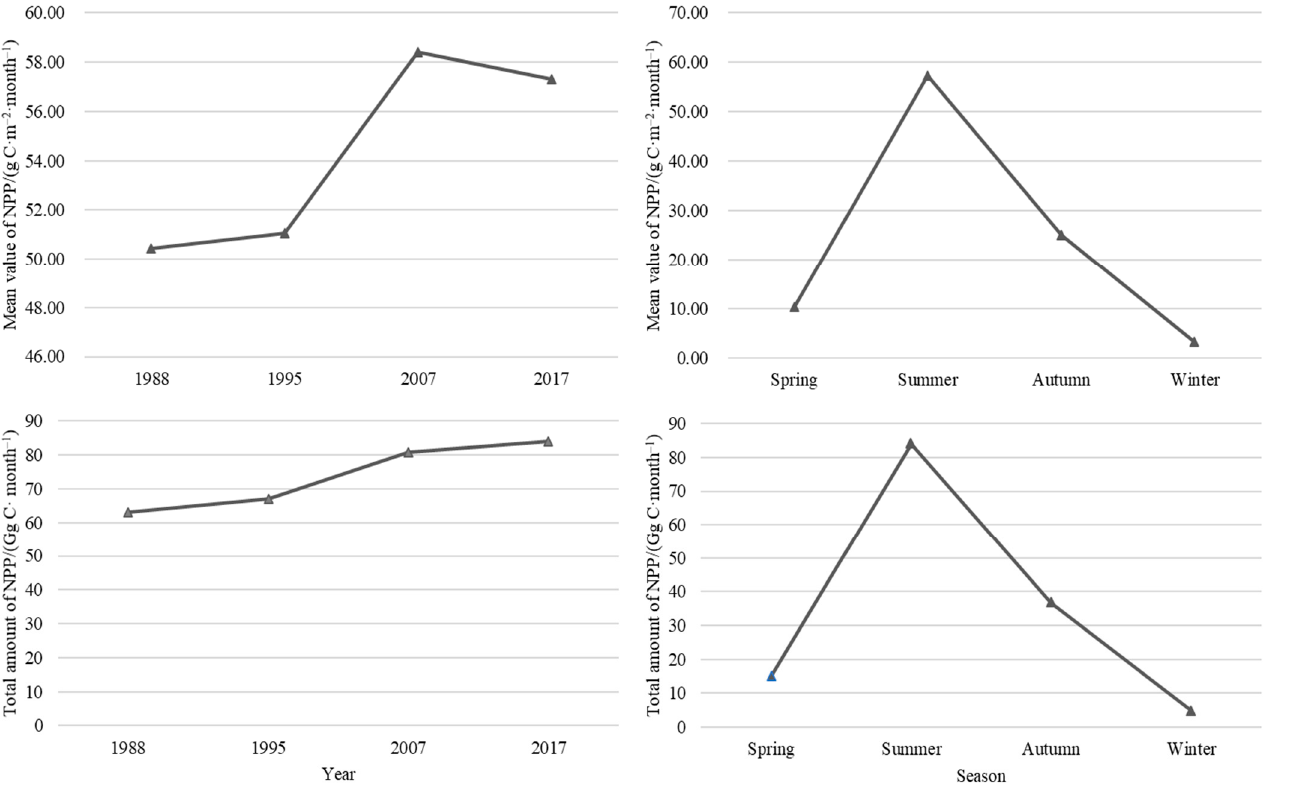
Figure 4. Temporal variation of NPP in the whole study area.